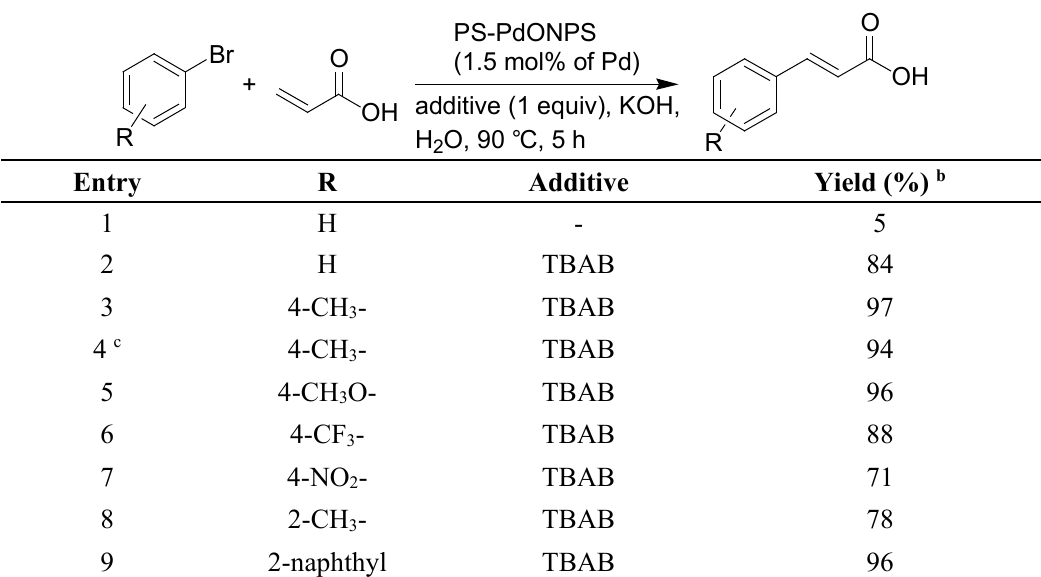
Table 3. Heck reaction of aryl bromide with acrylic acid a .